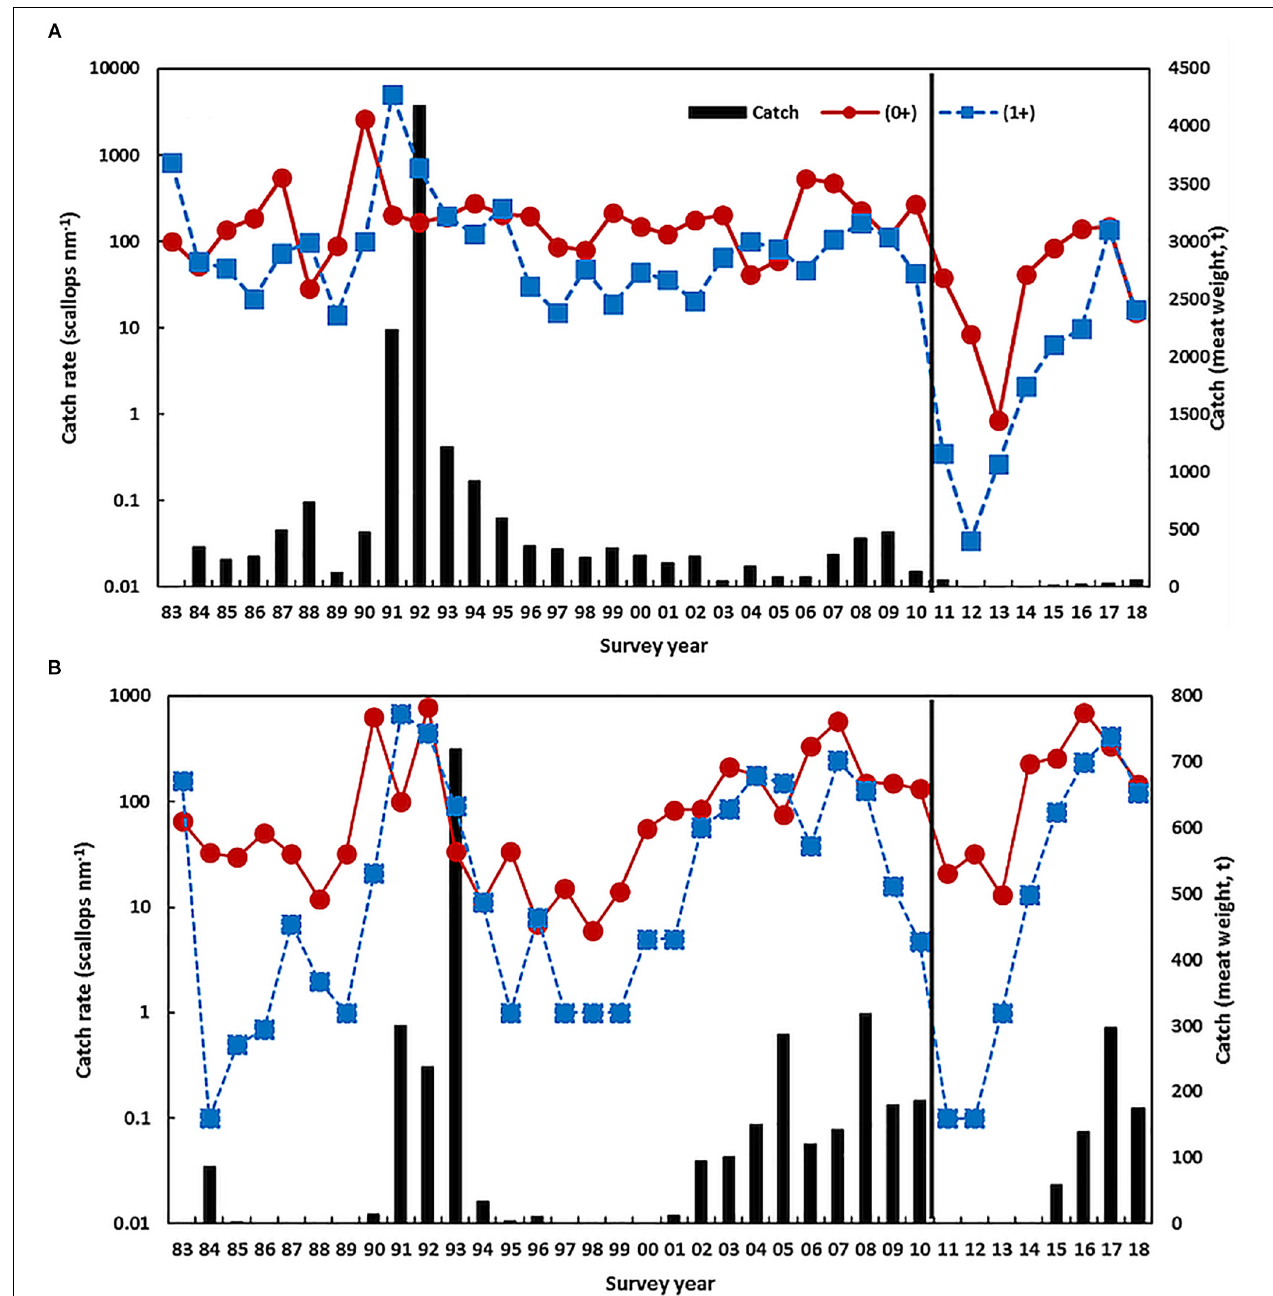
FIGURE 4 | Scallop juvenile recruitment (0 +) and adult (1 +) catch rate from November trawl surveys on a log scale and the catch (t, vertical bars) in (A) northern Shark Bay and (B) Denham Sound. The vertical line indicates the occurrence of the